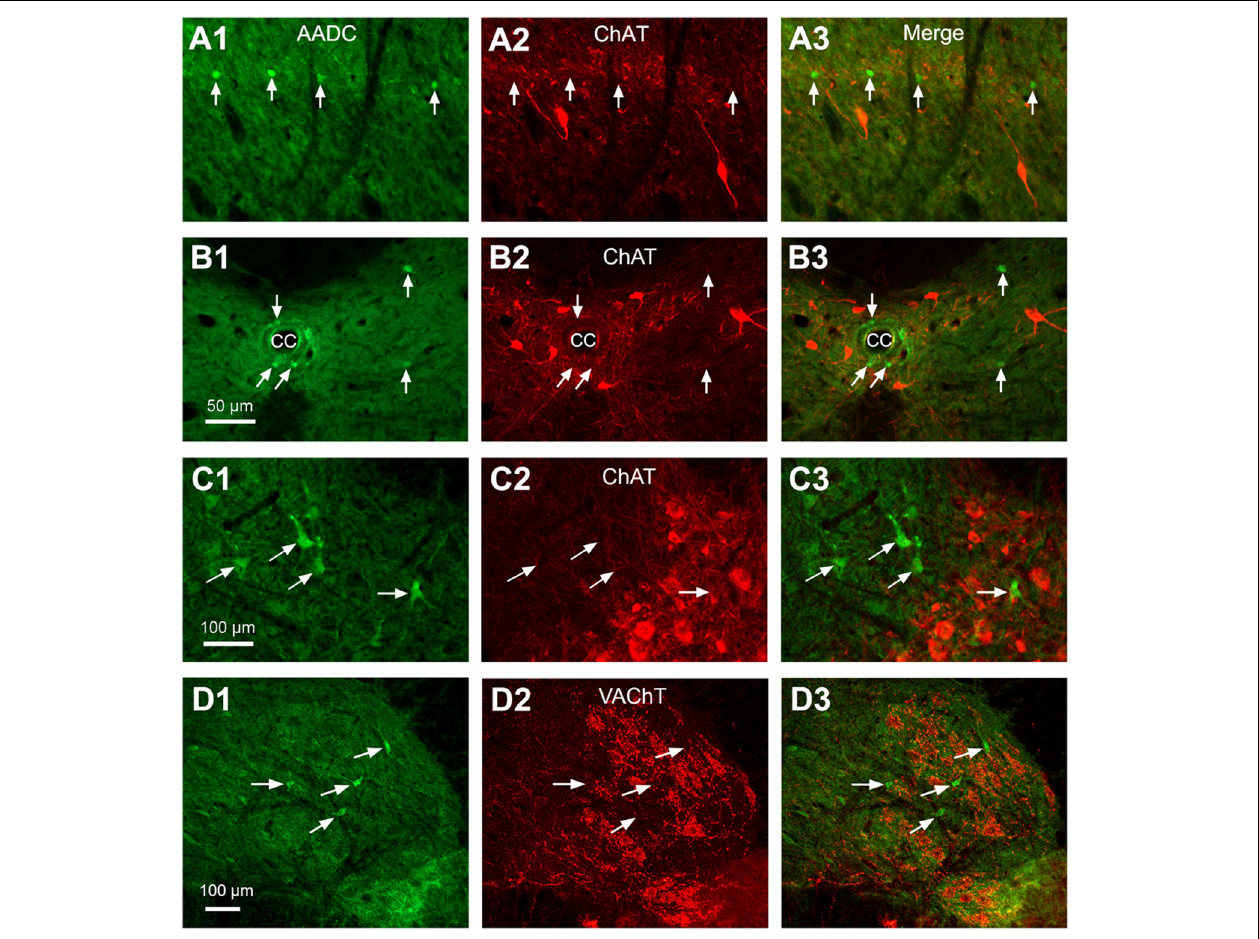
FIGURE 4 | Double-immunostaining indicates that AADC neurons did not express ChAT or VAChT in different parts of the spinal gray matter. (A1–A3) In the DH. (B1–B3) Around the CC. (C1–C3) In the intermediate zone/ventral horn. In (C3) a ChAT-immunonegative AADC cell was located in a cluster of ChAT-immunoreactive (IR) motoneurons. (D1–D3) In the ventral horn VAChT-IR neurons did not express AADC. All images were from transverse sections at lumbar (L) segments. Arrows in different panels indicate AADC-IR cells. Cells colored red are ChAT- or VAChT-IR cells. AADC antibody was from rabbit. Scale bar in (B1) , valid for (A1–B3) , 50 µ m; in (C1) , valid for (C1–C3) , and in (D1) , valid for (D1–D3) , 100 µ